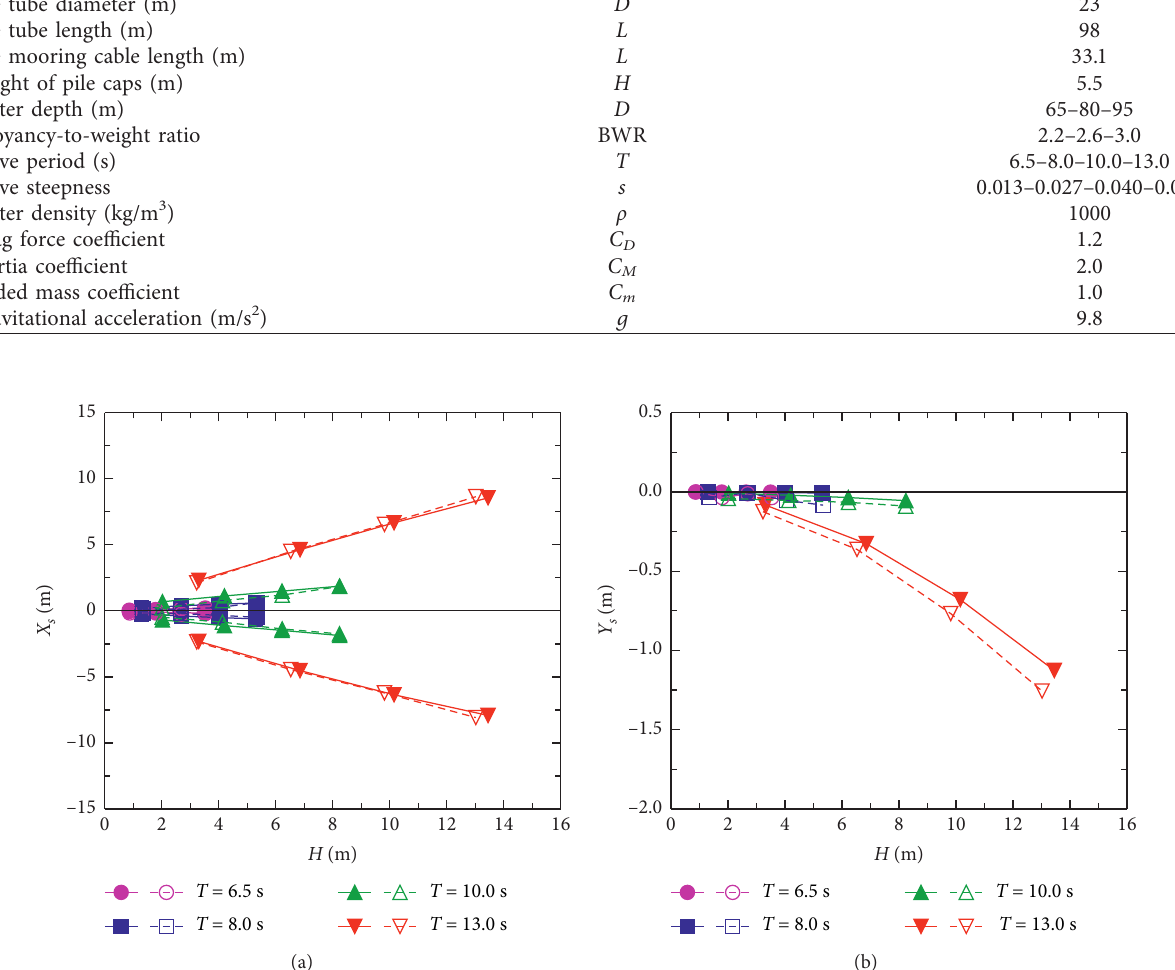
Figure 3: The average maximum value of (a) horizontal and (b) vertical tube displacements as a function of wave height H. Solid lines and solid markers are numerical simulation results; dotted line and open markers are experimental